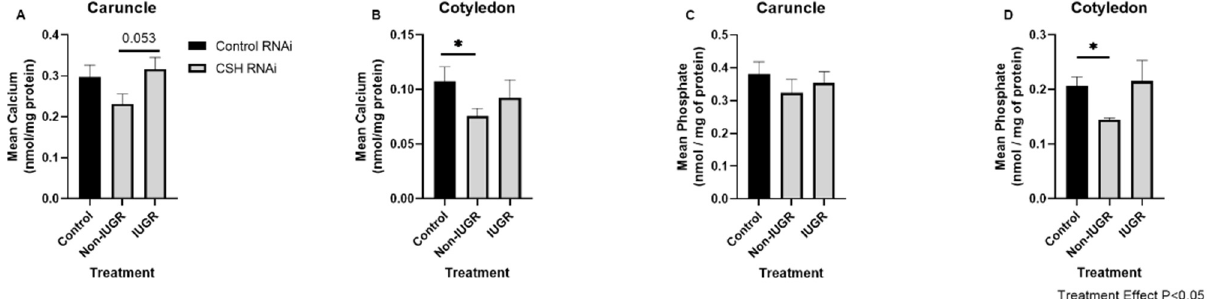
Figure 2. Abundances of calcium ( A , B ) and phosphate ( C , D ) in caruncles ( A , C ) and cotyledons ( B , D ) from Control RNAi, CSH RNAi Non-IUGR, and CSH RNAi IUGR pregnancies. Data are presented as means ± SEM. Control RNAi, n = 10; CSH RNAi Non-IUGR, n = 6; CSH RNAi IUGR, n = 4. CSH, chorionic somatomammotropin; IUGR, intrauterine growth restriction; RNAi, RNA interference. * p < 0.05.